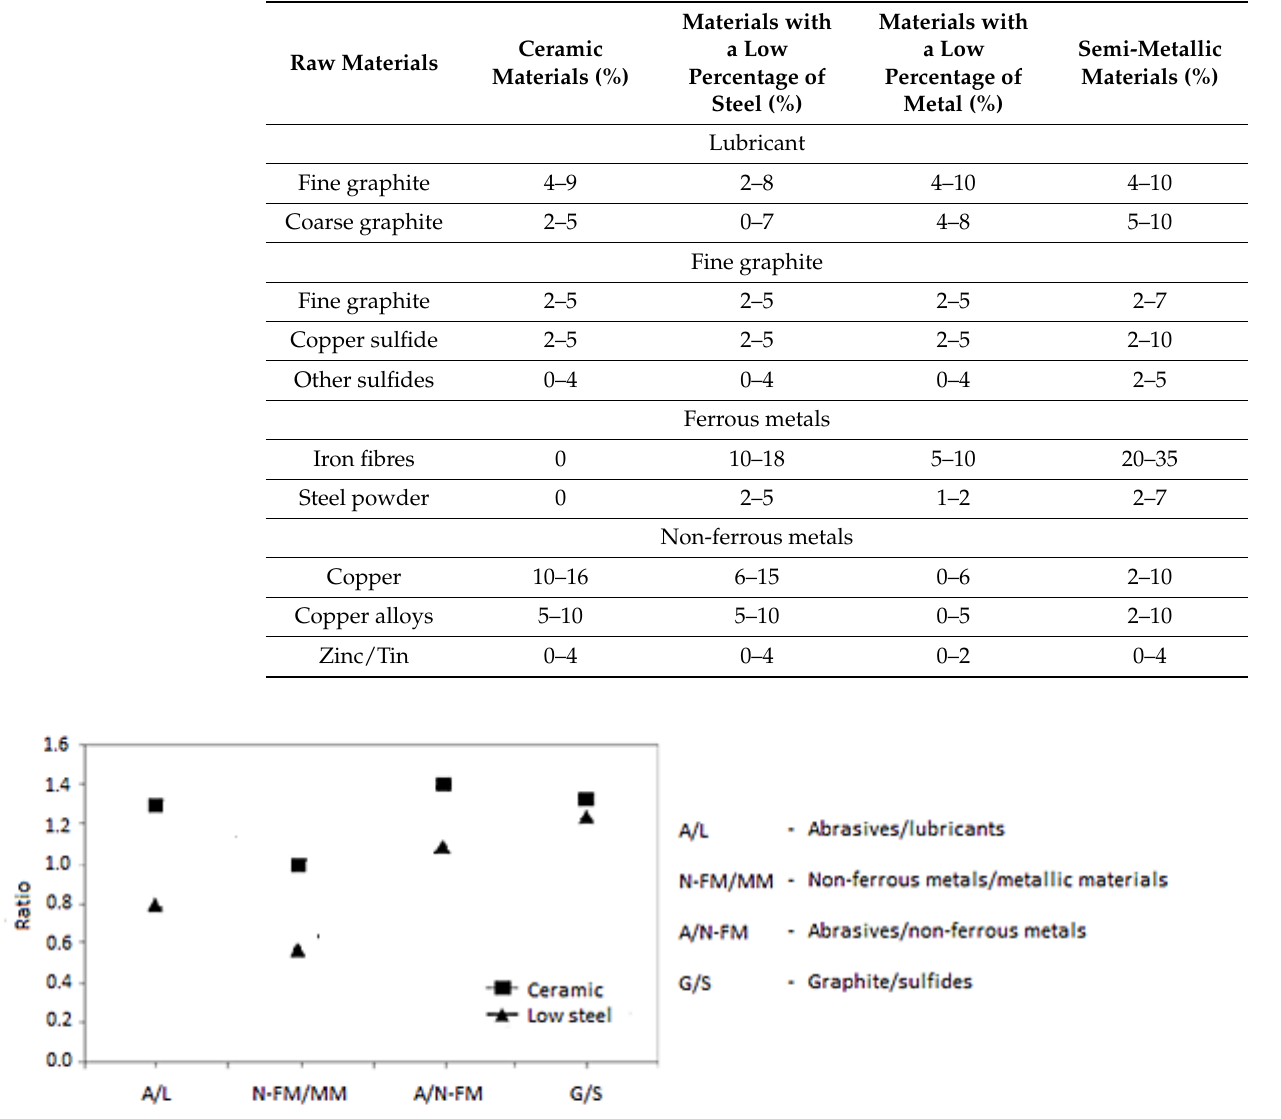
(C/C-SiC), were used as friction materials and their microstructure is shown in Figure